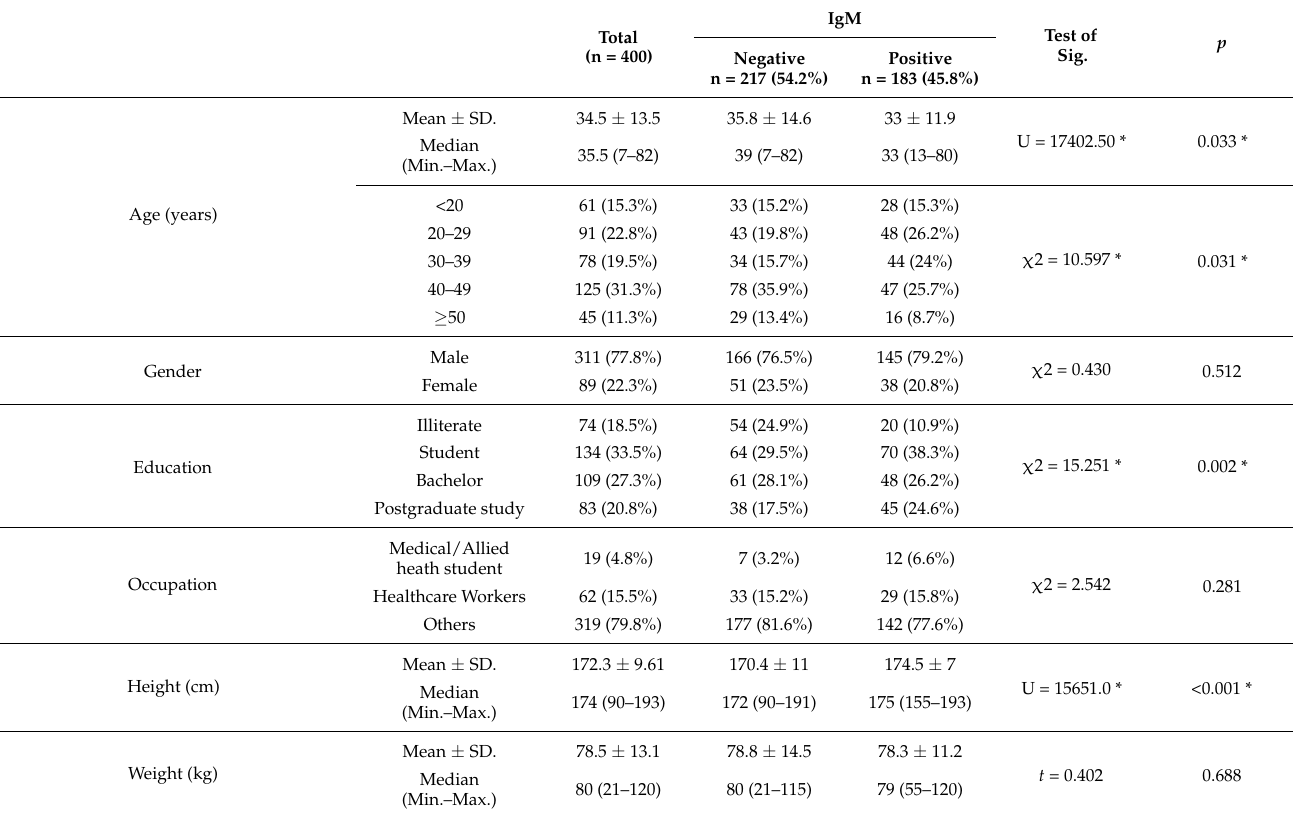
Table 2. Comparison of the history, demographics, anthropometrics, and lifestyle of the participants stratified for the extent of anti-SARS-CoV-2 IgM in their blood (Total n = 400). Data shown are frequencies; n. (%), and mean ± SD (median;